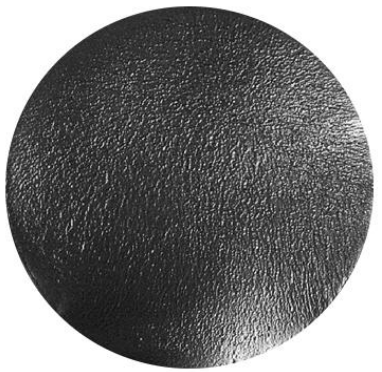
is the intruded Hg volume per gram of p